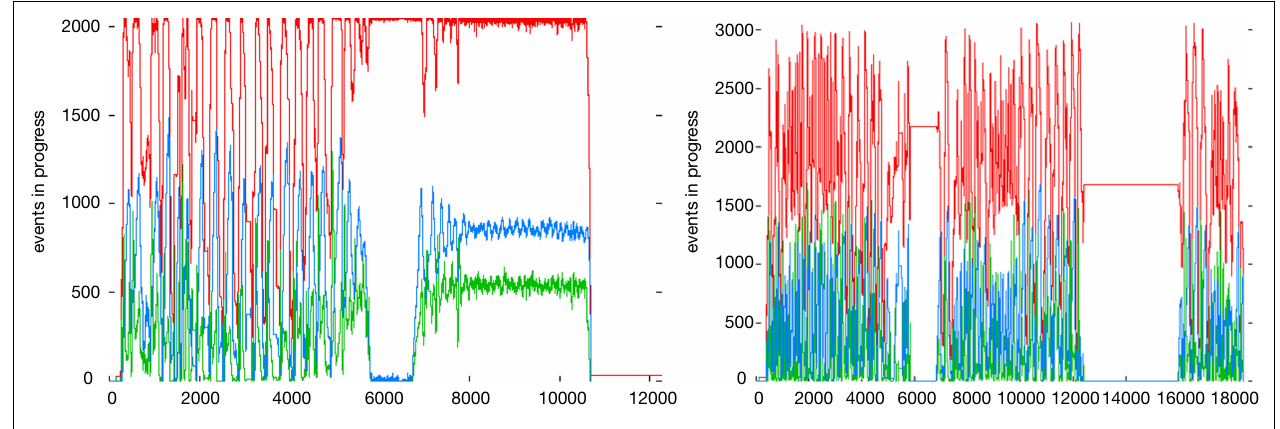
FIGURE 3 | Number of active processes during workfl ow execution: (left) Processing of the 4-region workfl ow over 2 experimental conditions . (Right) Processing of the 4-region workfl ow over multiple networks. The red line